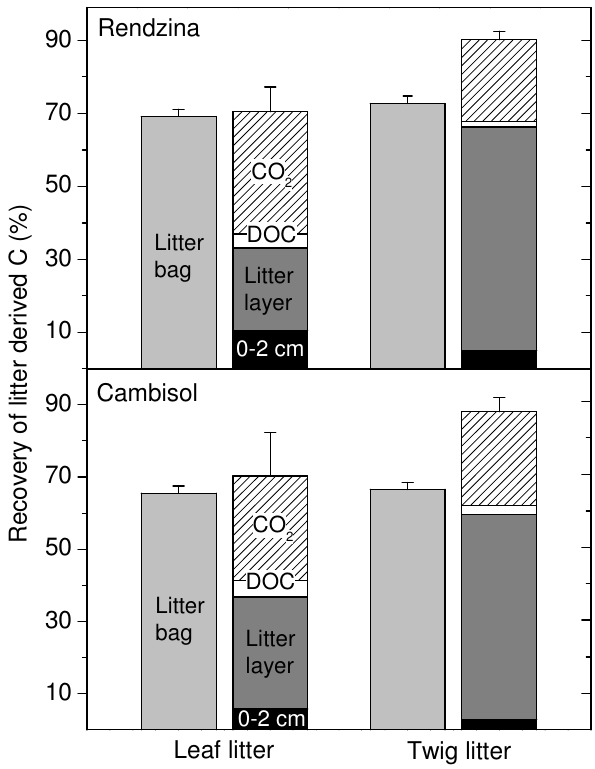
Fig. 1. Total recovery of the 13 C-labelled litter C in litterbags and in different C fluxes and C pools after 1 year of decomposition. Means and standard errors of five replicates. 3